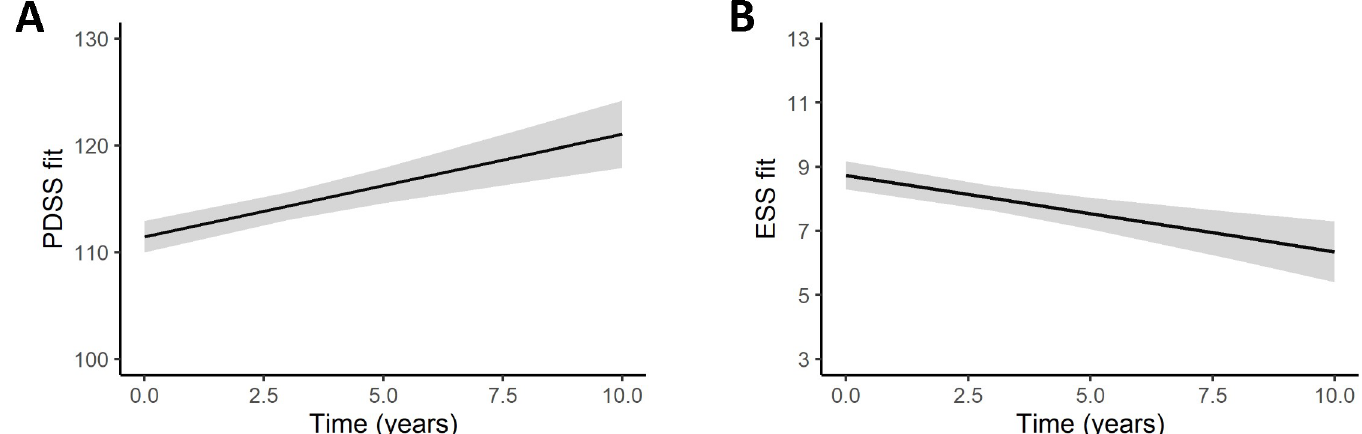
Fig 2. Progression of nocturnal sleeping disturbances and excessive daytime sleepiness in Parkinson’s disease over time. Parameter estimates from linear mixed models are plotted. Lines represent the mean and shadowed grey background the SE of the estimation. Abbreviations: ESS, Epworth Sleepiness Scale total score; PDSS, Parkinson’s disease Sleeping Scale total score.